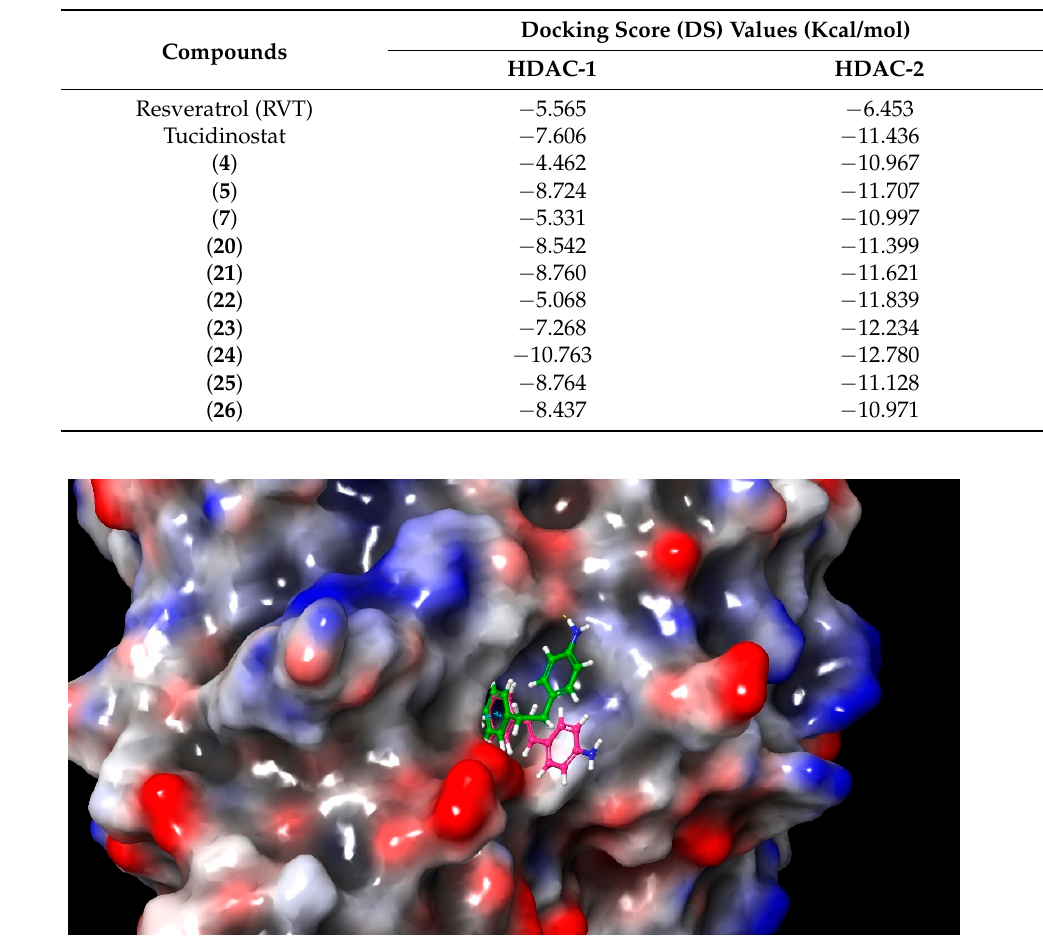
Table 1. Docking score values (Kcal/mol) for HDAC-1 and HDAC-2.